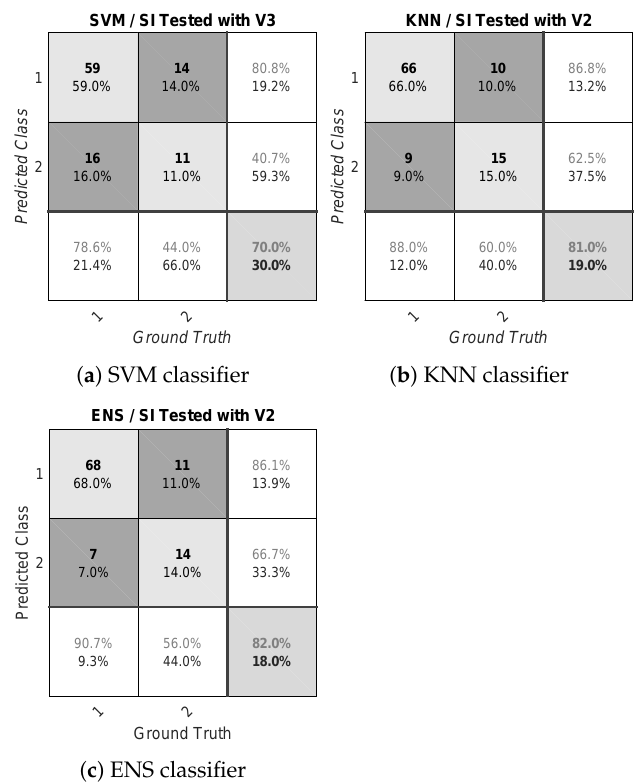
Figure A11. Confusion matrices for a subject-independent model tested with V1.